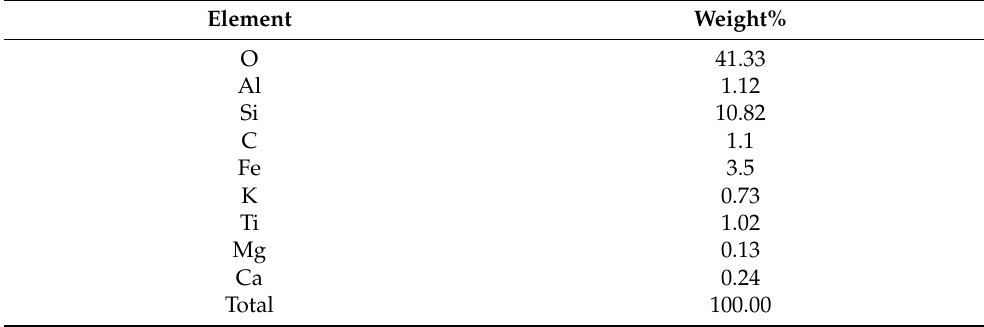
Table 3. Elemental composition of ISA by EDS adopted from Yadav et al. [14].